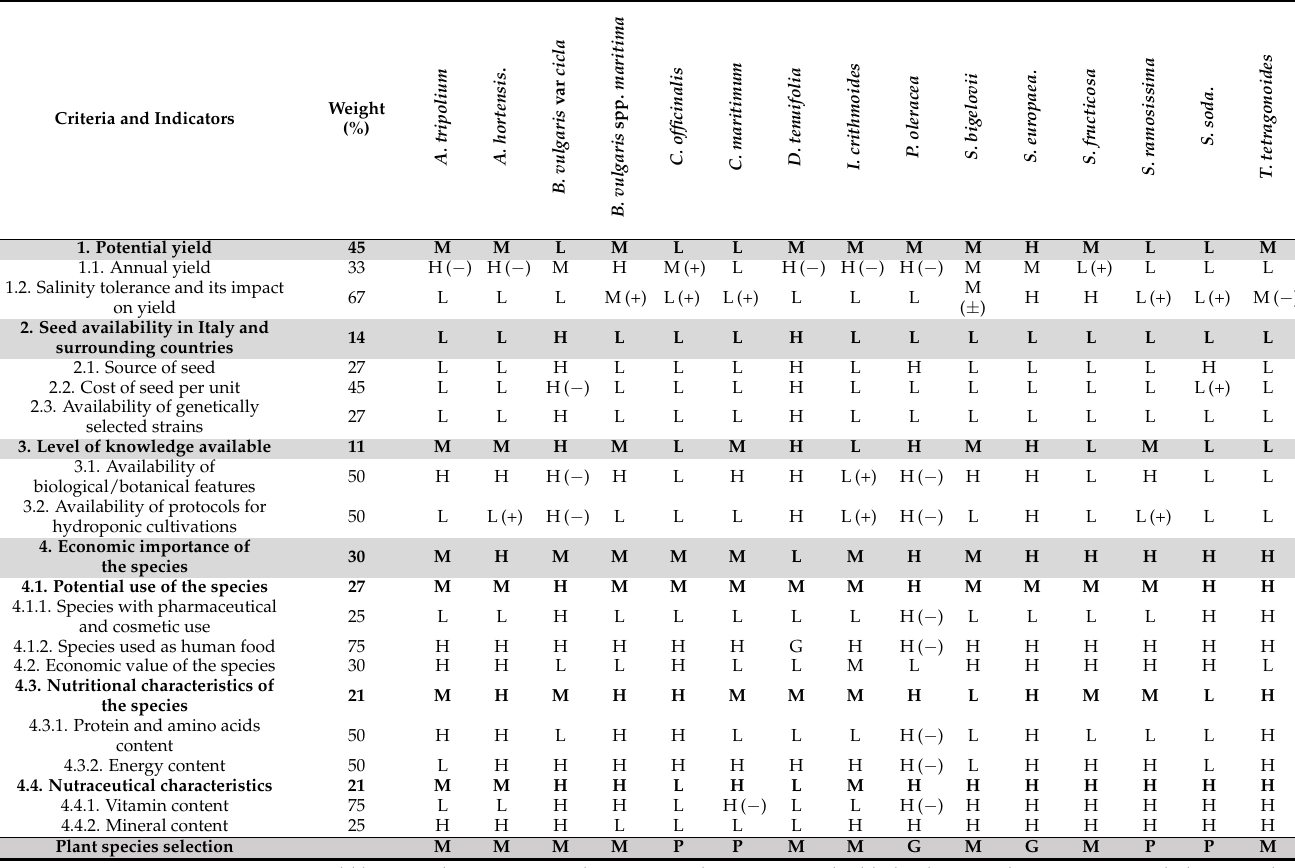
Table 9. Assigned scores and results of the considered plant species (with % of relevance of each indicator) and sensitivity analysis for criteria, for the higher salinity (35 g L − 1 ) scenario.